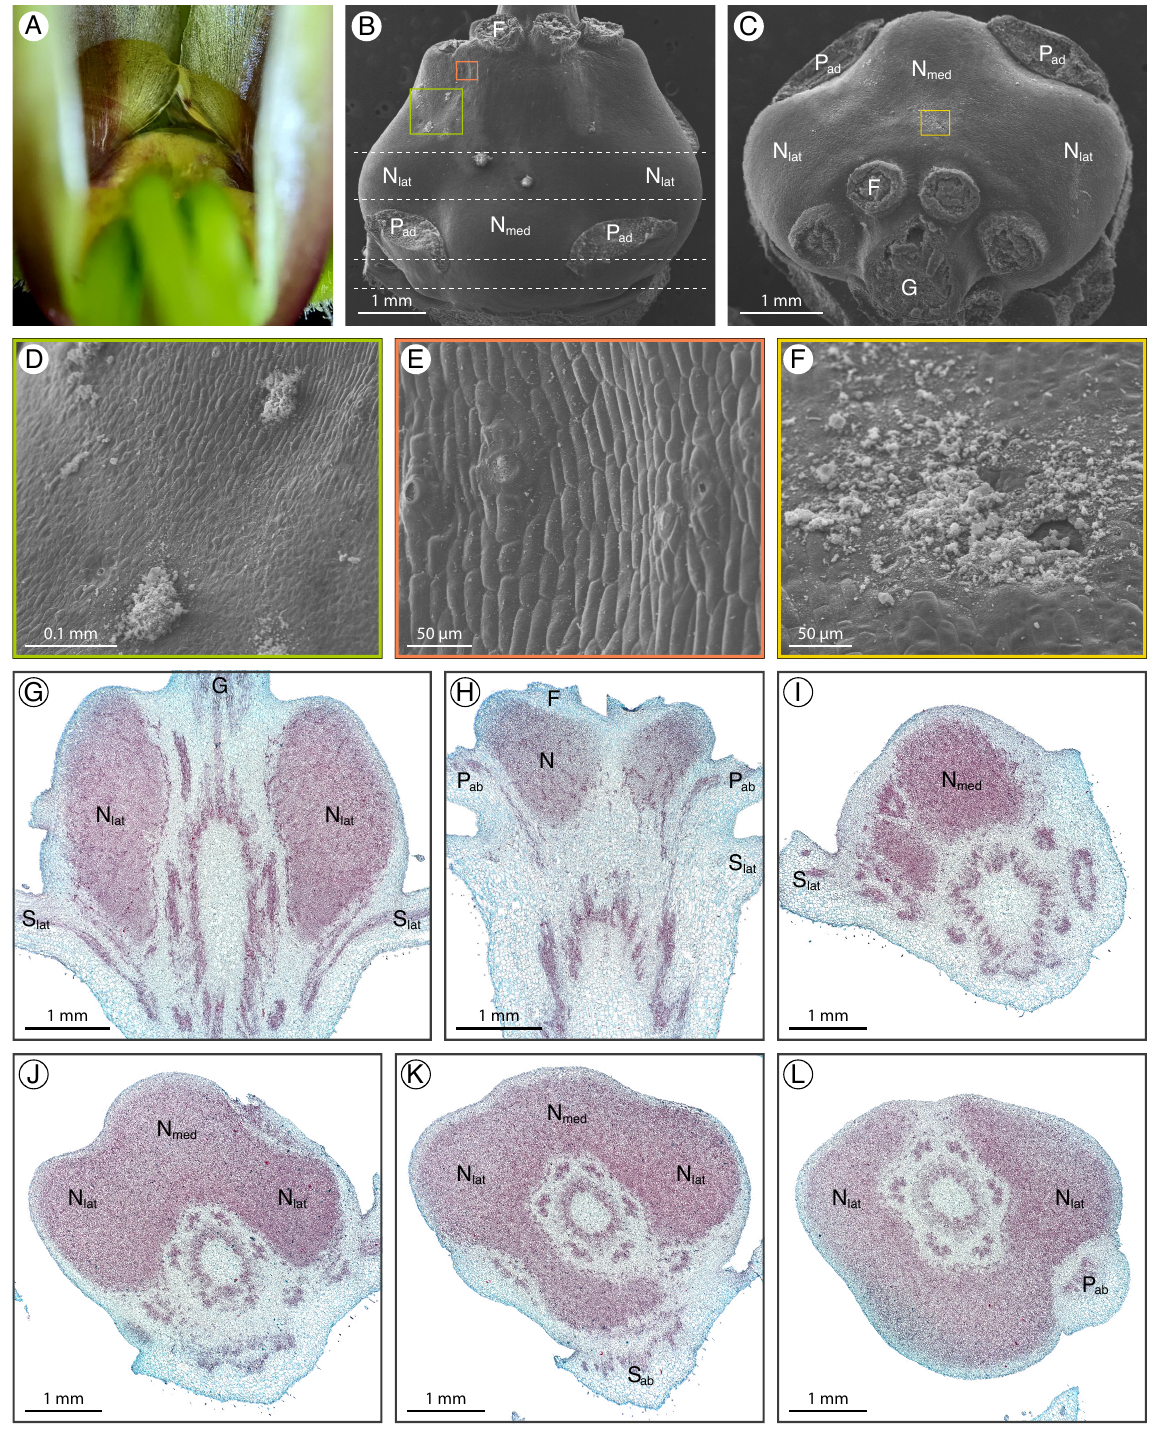
Figure 6. Melidiscus giganteus nectary ( A ) photograph, ( B – F ) scanning electron micrographs, and ( G – L ) fast green and safranin O-stained sections. ( A ) Apical view of the nectary. ( B ) Adaxial view of the nectary. ( C ) Apical view of the nectary. ( D , E ) Adaxial view close-ups, corresponding to the bottom and top boxes in ( B ), respectively. ( F ) Apical view close-up, corresponding to the box in ( C ). ( G , H ) Longitudinal sections (frontal plane): ( G ) lateral nectary lobes and ( H ) abaxial side of nectary. ( I – L ) Transverse sections of the nectary, corresponding to the dashed lines in ( B ) from proximal to distal, respectively. All images are of anthetic stage specimens. F: filament; G: gynophore; N lat : lateral nectary lobe; N med : medial nectary lobe; P ab : abaxial petal; P ad : adaxial petal; S ab : abaxial sepal; S ab : abaxial sepal; S lat : lateral